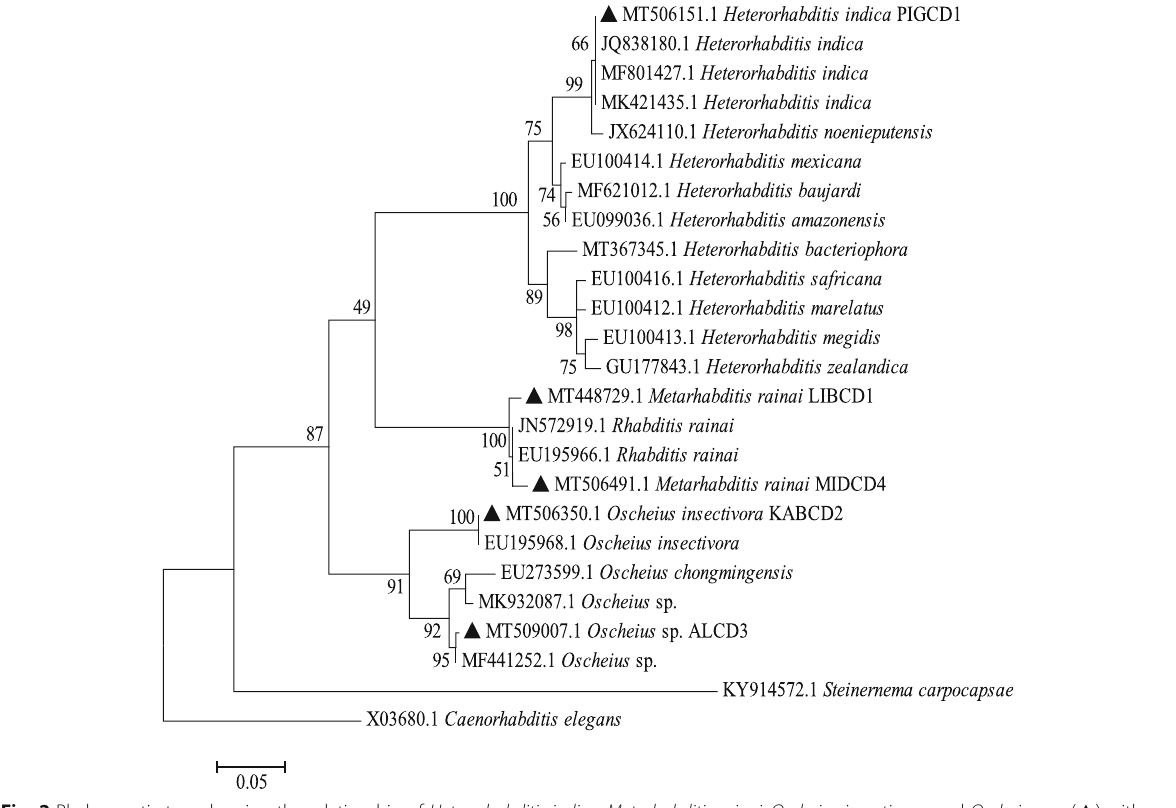
Fig. 2 Phylogenetic tree showing the relationship of Heterorhabditis indica , Metarhabditis rainai , Oscheius insectivora , and Oscheius sp. ( ▲ ) with other related species using the maximum likelihood method (with 1000 bootstrap values). Caenorhabditis elegans and Steinernema carpocapsae were used as outgroup taxa. Numbers before each species indicate the GenBank Accession numbers